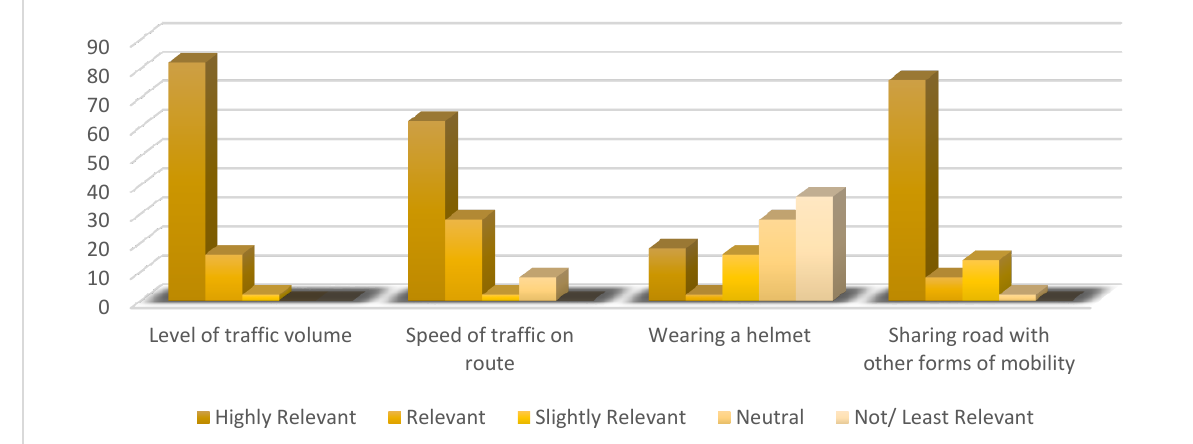
Figure 4: Perception of cyclist’s safety in Johannesburg